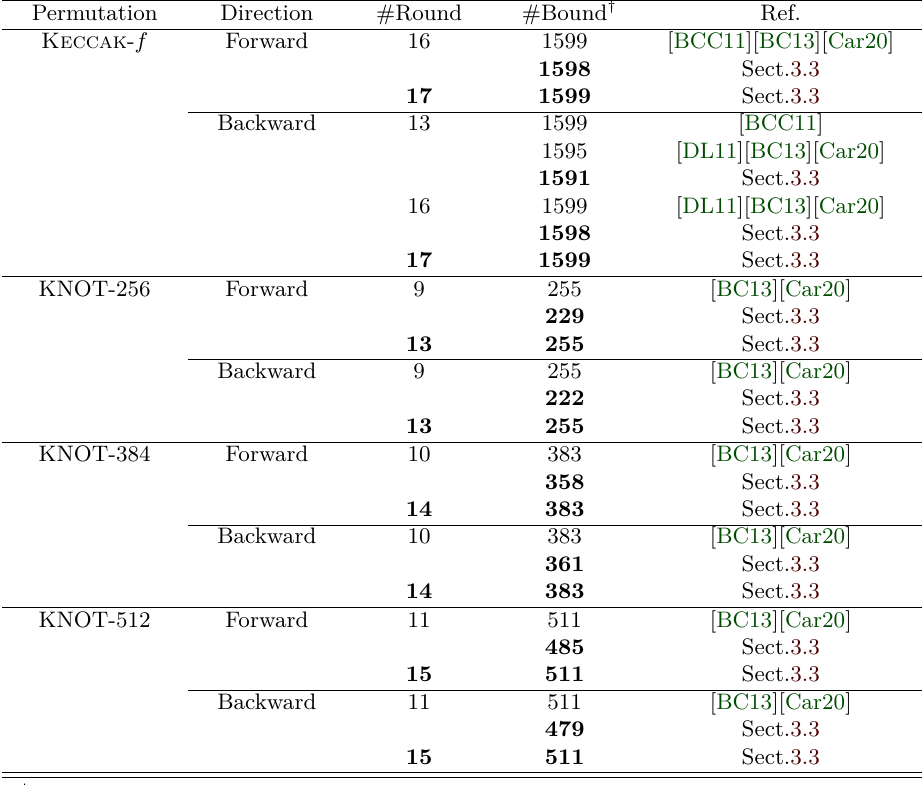
Table 1: The upper bounds on degree of the permutations of Keccak , KNOT and their